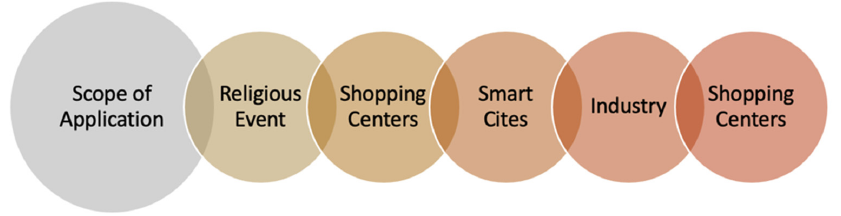
Figure 5. Scope of